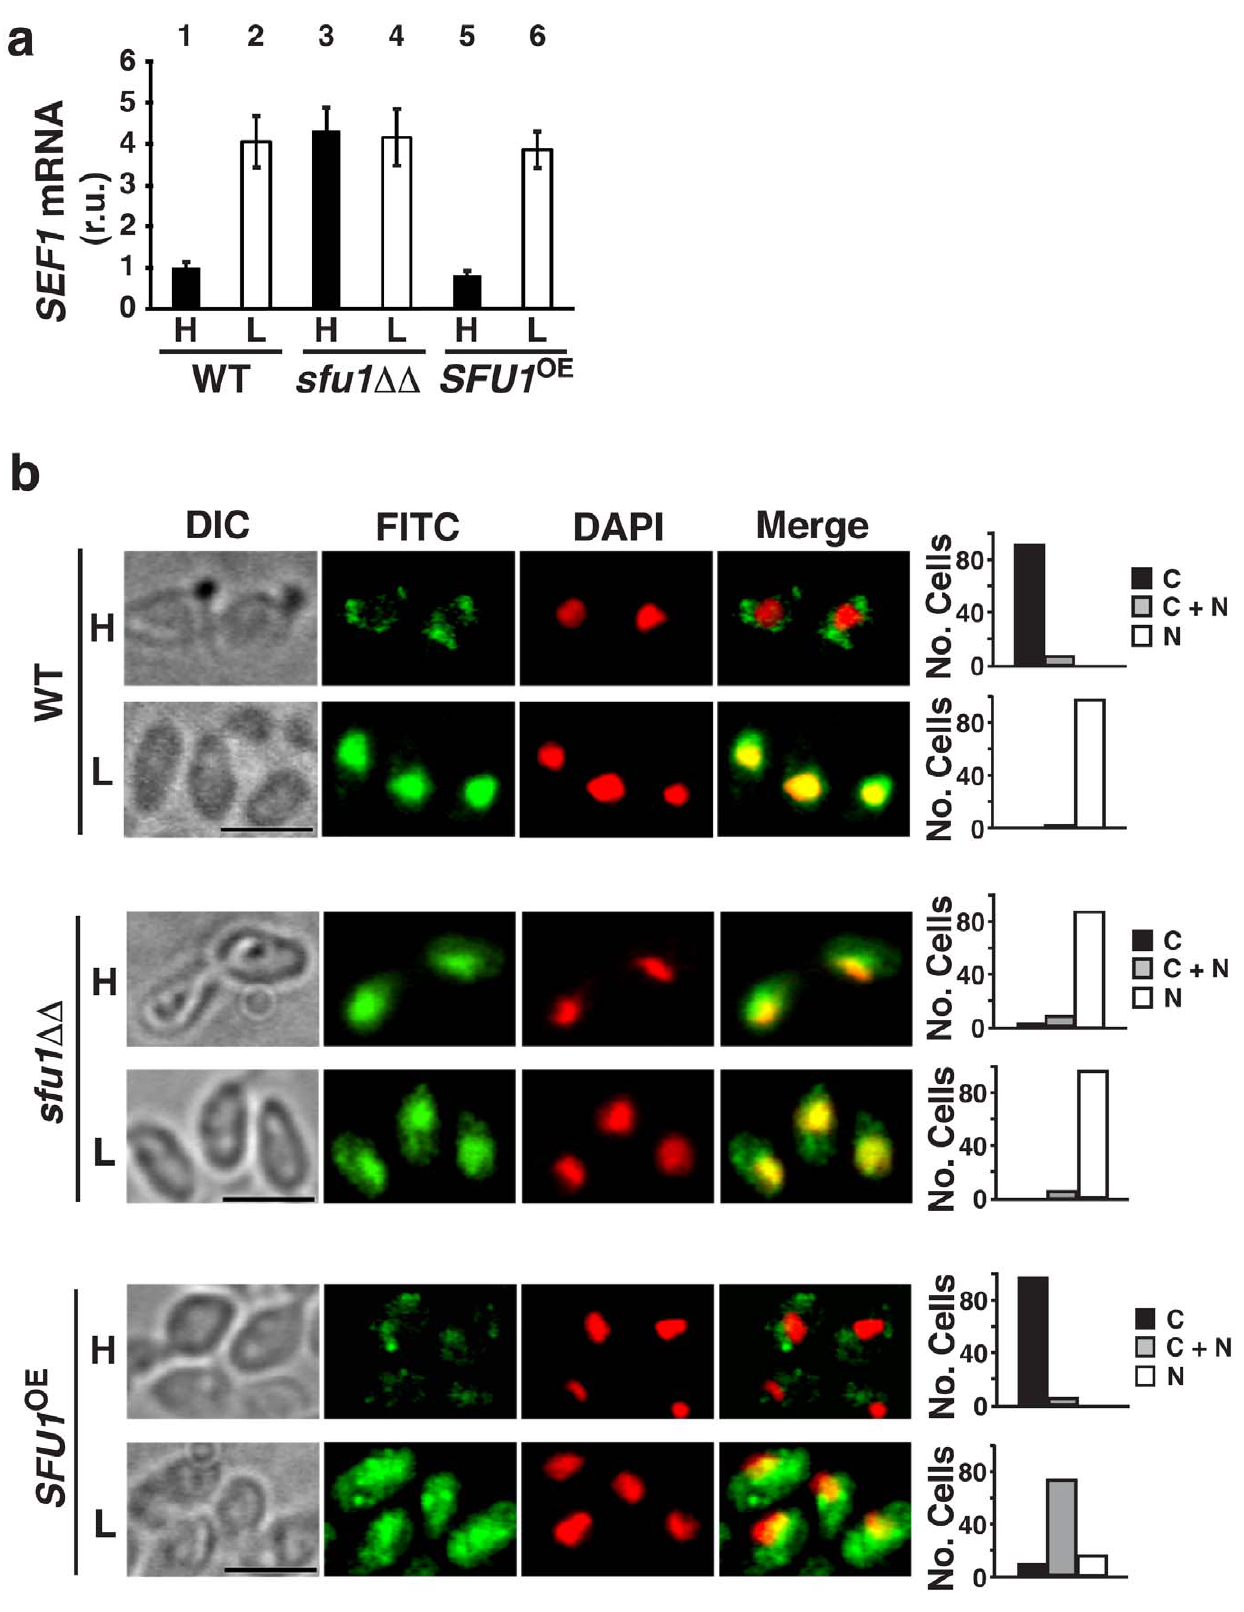
Figure 1. Sfu1 regulates SEF1 gene expression and localization of Sef1 protein. Note that C. albicans gene deletion mutants are represented as DD because two alleles of target genes must be disrupted in this obligate diploid species. a) RT-qPCR results for SEF1 mRNA in wild- type (WT), sfu1 DD , and SFU1- overexpression ( SFU1 OE ) strains grown under iron-replete (H, high iron) or iron-depleted (L, low iron) conditions. Error